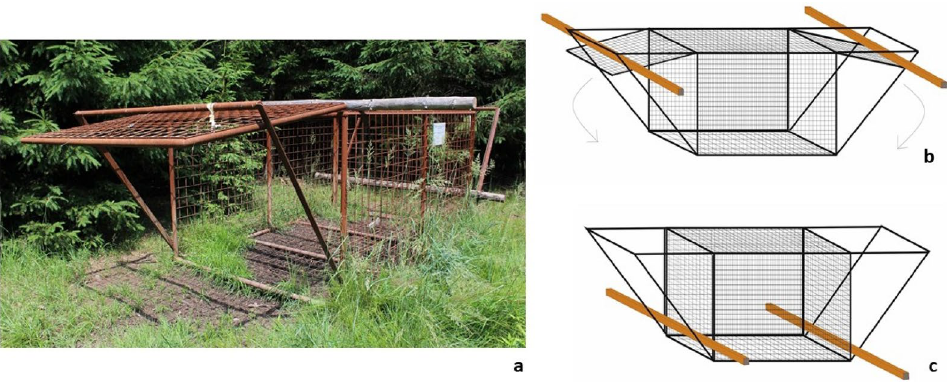
Figure 1. A box trap used for trapping wild boar at the study location ( a ). The open tipping door is secured by a wire. One end of the wire is attached to the door and the other end is hooked to the bottom of cage. The door is closed by manipulating the hook of the wire from inside the trap, usually during rooting. For a detailed photo of trigger mechanism, see Supplementary electronic material, SEM (Fig S1). Triggering the mechanism closes the door and releases the logs which secure the doors from the outside ( b , c